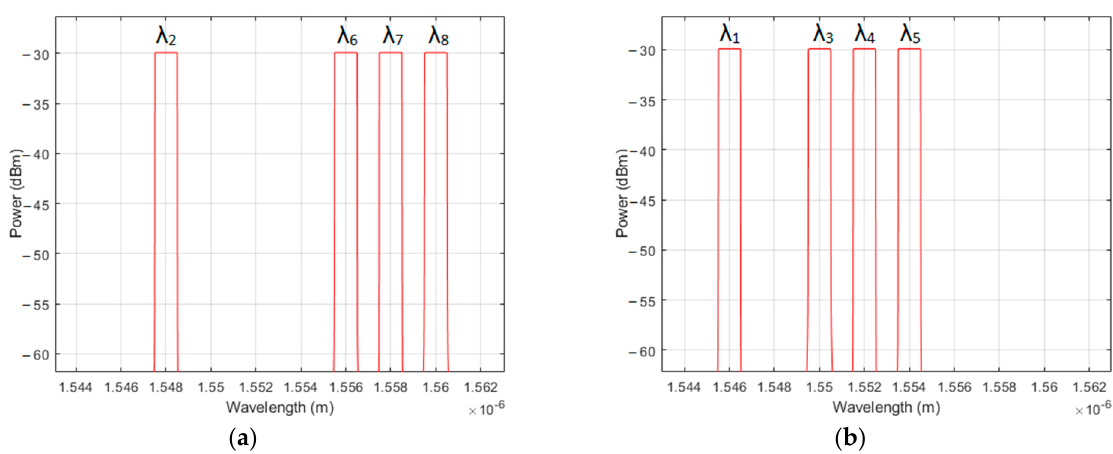
Figure 5. Output spectrum after transmission over FSO channel for user data bits of “1”: ( a ). horizontal polarization; ( b ). vertical polarization.